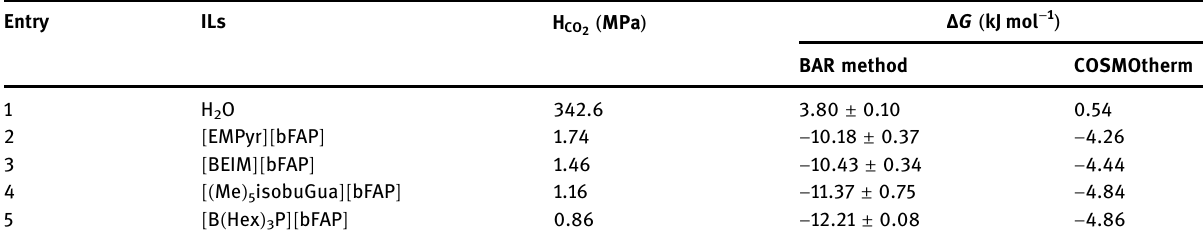
Table 1: Henry constant and solvation free energy of CO 2 in ILs Entry